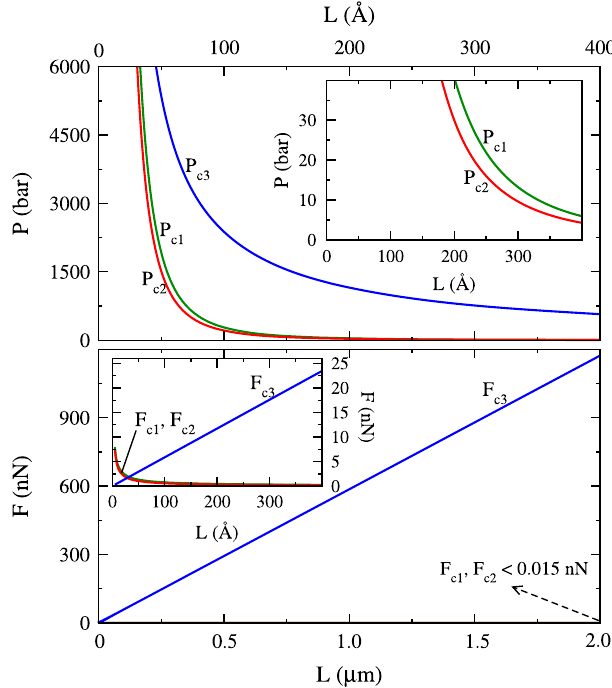
Fig. 1 Calculated critical pressures P c1 , P c2 , P c3 according to Eqs. 7, 10, 11 for uniform load ( top panels ) and critical forces F c1 , F c2 , F c3 for point load ( bottom panels ) as a function of system size L on two different scales, in the absence of prestrain. The inset zoom in at different load and/or size range